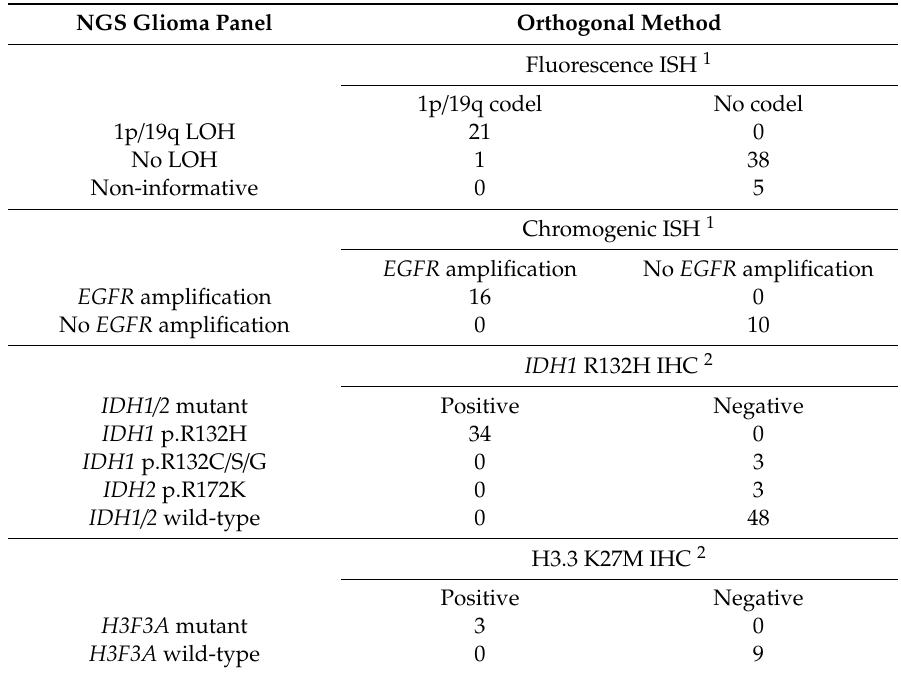
Table 1. Summarized results of the next-generation sequencing (NGS) validation performed using orthogonal